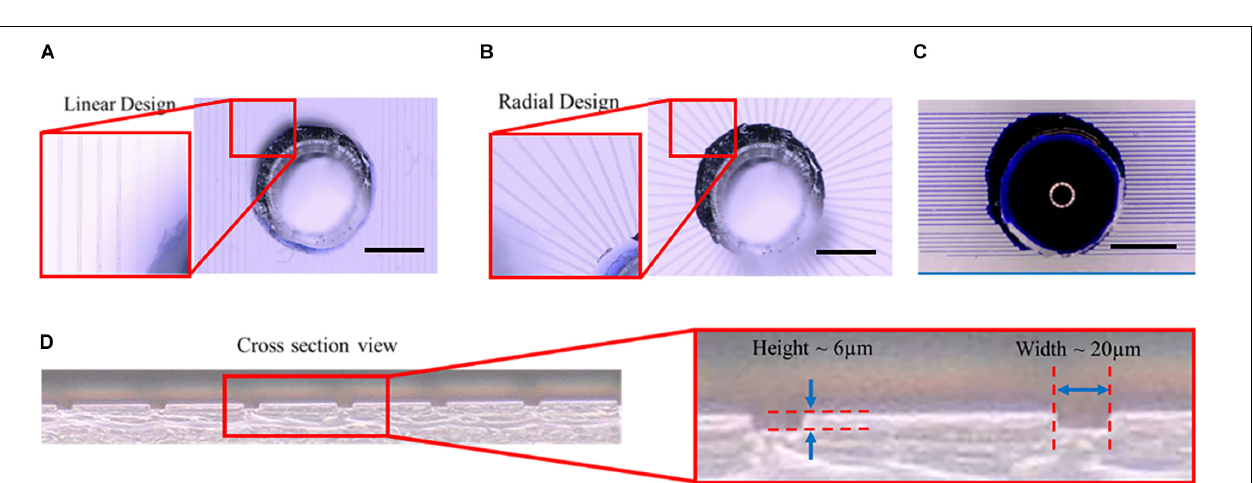
culture on 1 mm 2 of flat substrate was 513.8 ± 257.8 µ m with